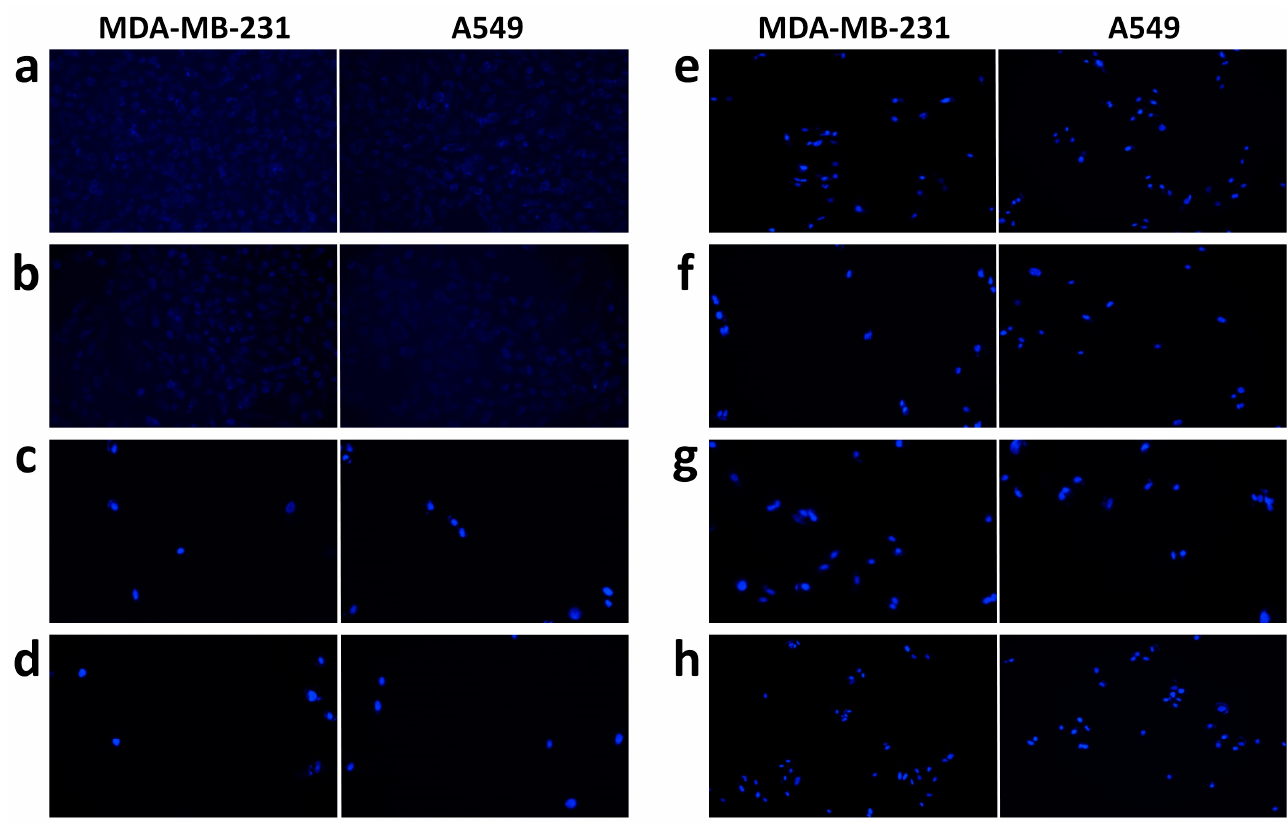
Figure 8. Nucleus changes due to cytotoxic e ff ect by control, free drugs, and drug(s)-loaded nanoliposomes on MDA-MB-231 and A549 cell lines. ( a ) Control, ( b ) free liposomes, ( c ) free CDDP, ( d ) free DADS, ( e ) free CDDP/DADS, ( f ) Lipo-CDDP, ( g ) Lipo-DADS, and ( h ) Lipo-CDDP/DADS.